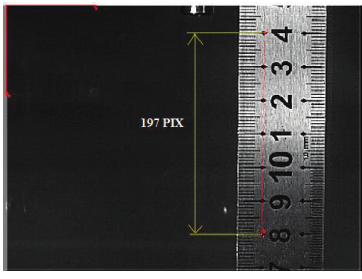
Figure 4: Image size